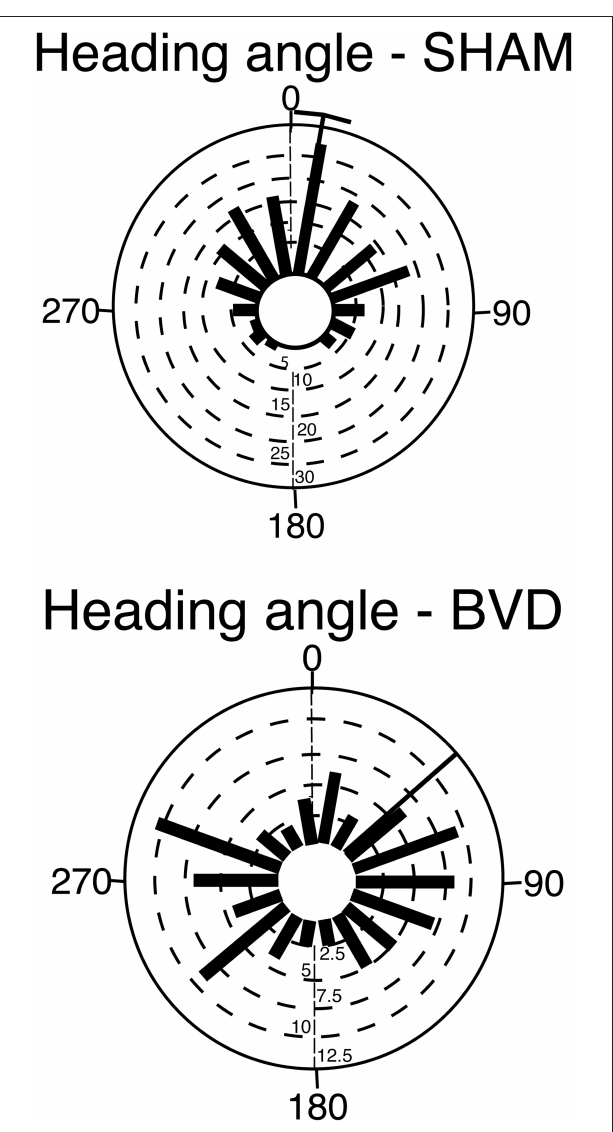
Figure 1 | rose plots of the heading angle of rats subjected to bilateral vestibular deafferentation (BVD) or sham surgery at 14 months post-op. The plots represent the animal’s direction on the homeward route in a foraging task in which they had to remember the location of a home base in darkness. In the plots, 0 ° represents the correct direction or heading angle. Each blue bar represents one animal and the black bars represent the mean heading angles for the group with a 95% confidence interval (for the sham group). Notice that the BVD animals’ heading angles were distributed equally around 360 ° and that, as a result, no 95% confidence interval could be calculated. Modified from Baek et al.